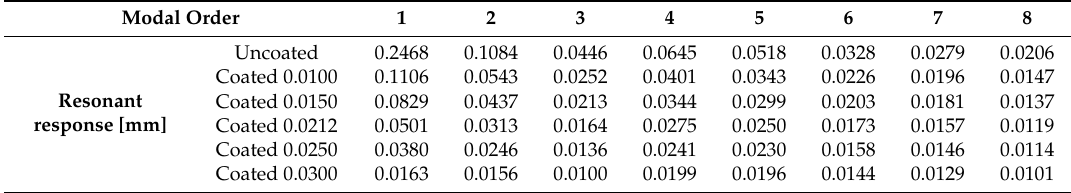
Figure 7. The modal loss factor of the composite shell corresponding to different loss factors of hard coating. Table 8. The influence of loss factor of hard coating on the resonant responses of the composite shell.